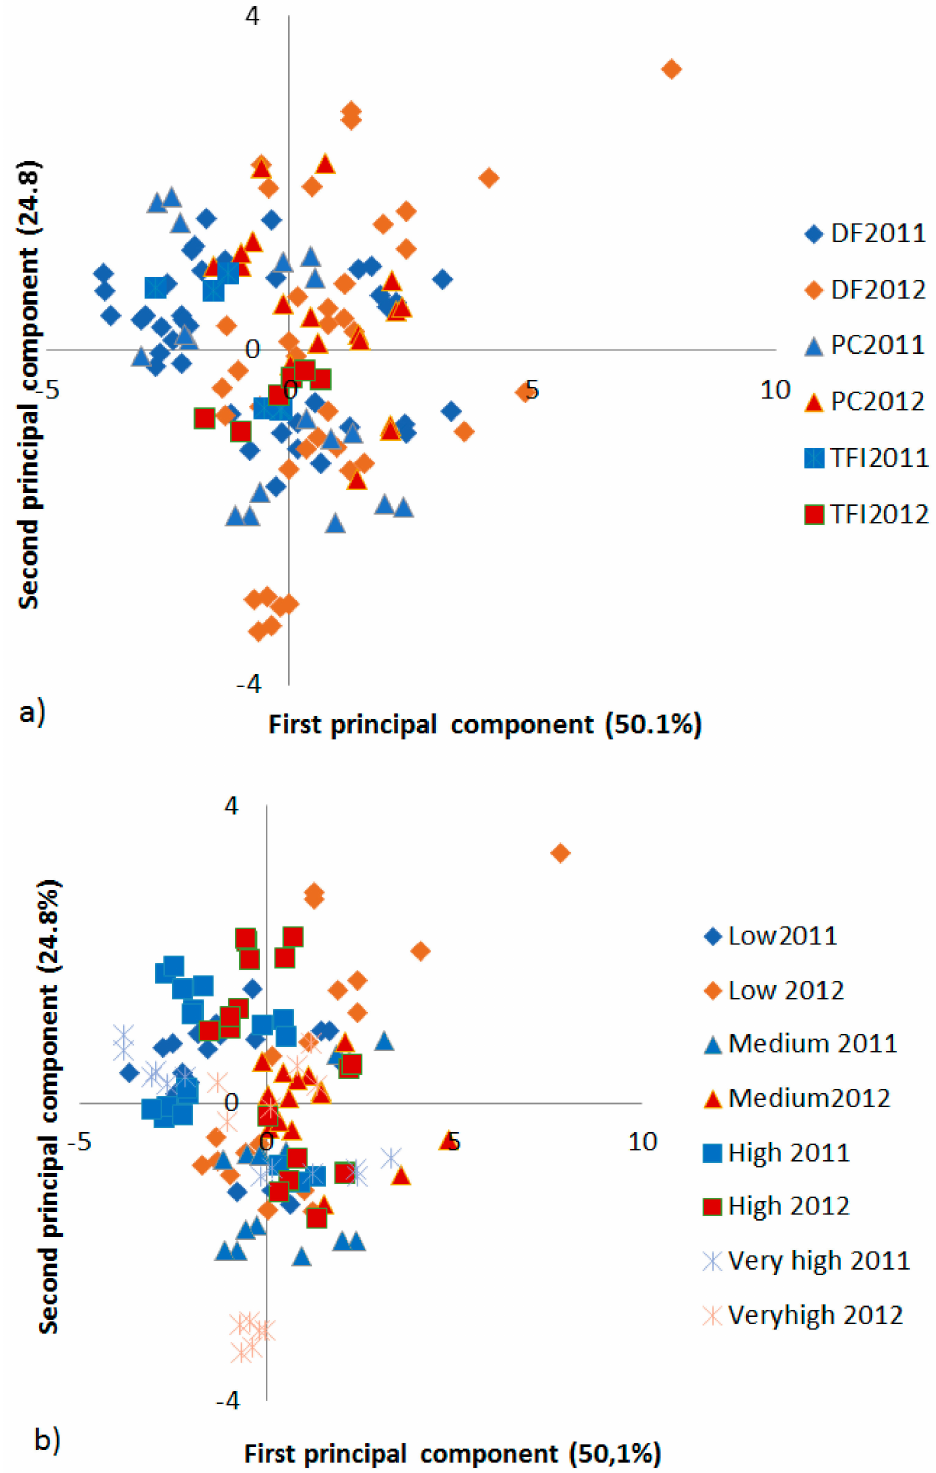
Figure 3. Score plot from a principal component analyses (PCA) of protein composition in wheat grain from farms ( a ) of different types (DF = dehkan farm; PC = production cooperative; TFI = Tajik Farming Institute farm) and grown during different years and ( b ) at different